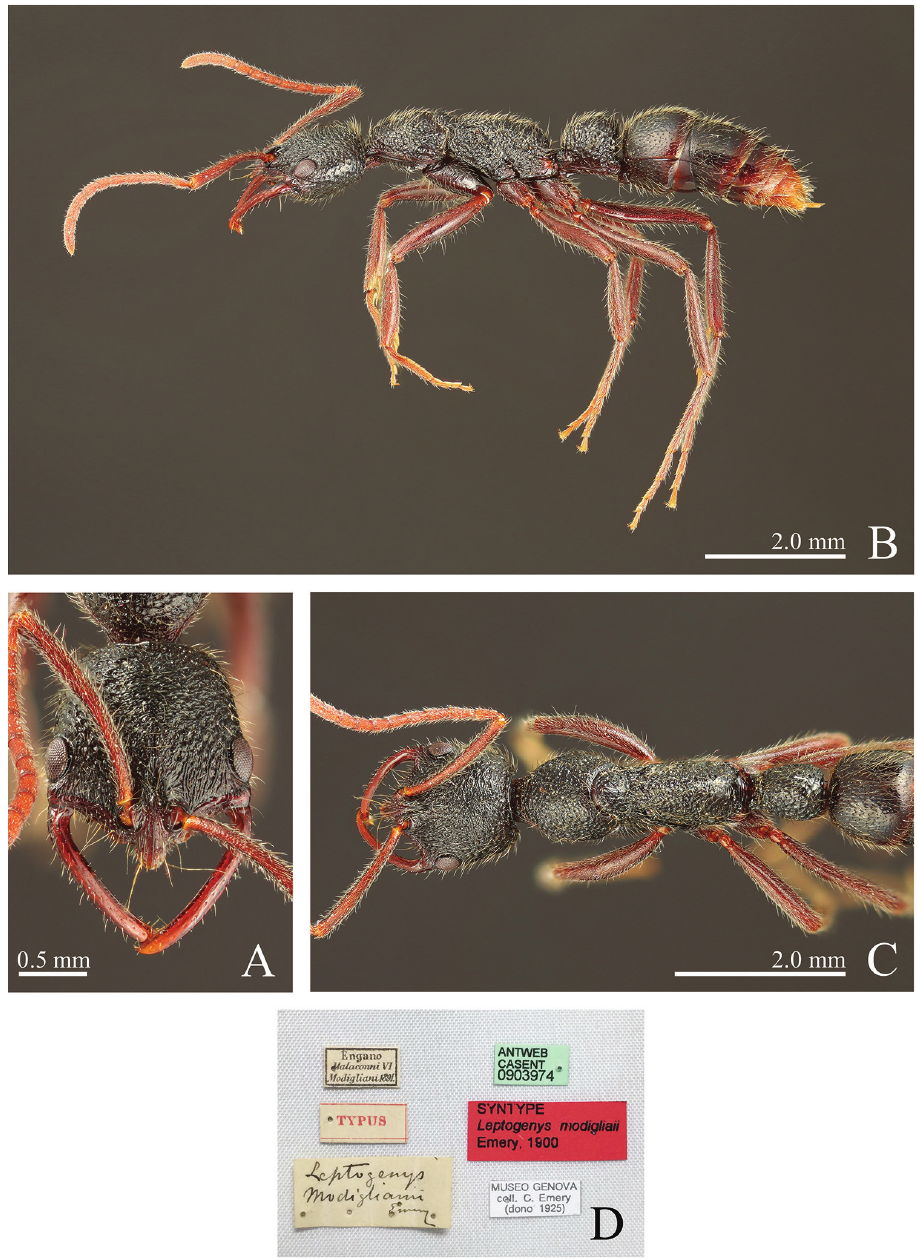
Figure 14. Leptogenys modiglianii Emery, 1900, lectotype, worker, specimen code: ANTWEB CASENT 0903974. A head, full-face view B lateral view C dorsal view D